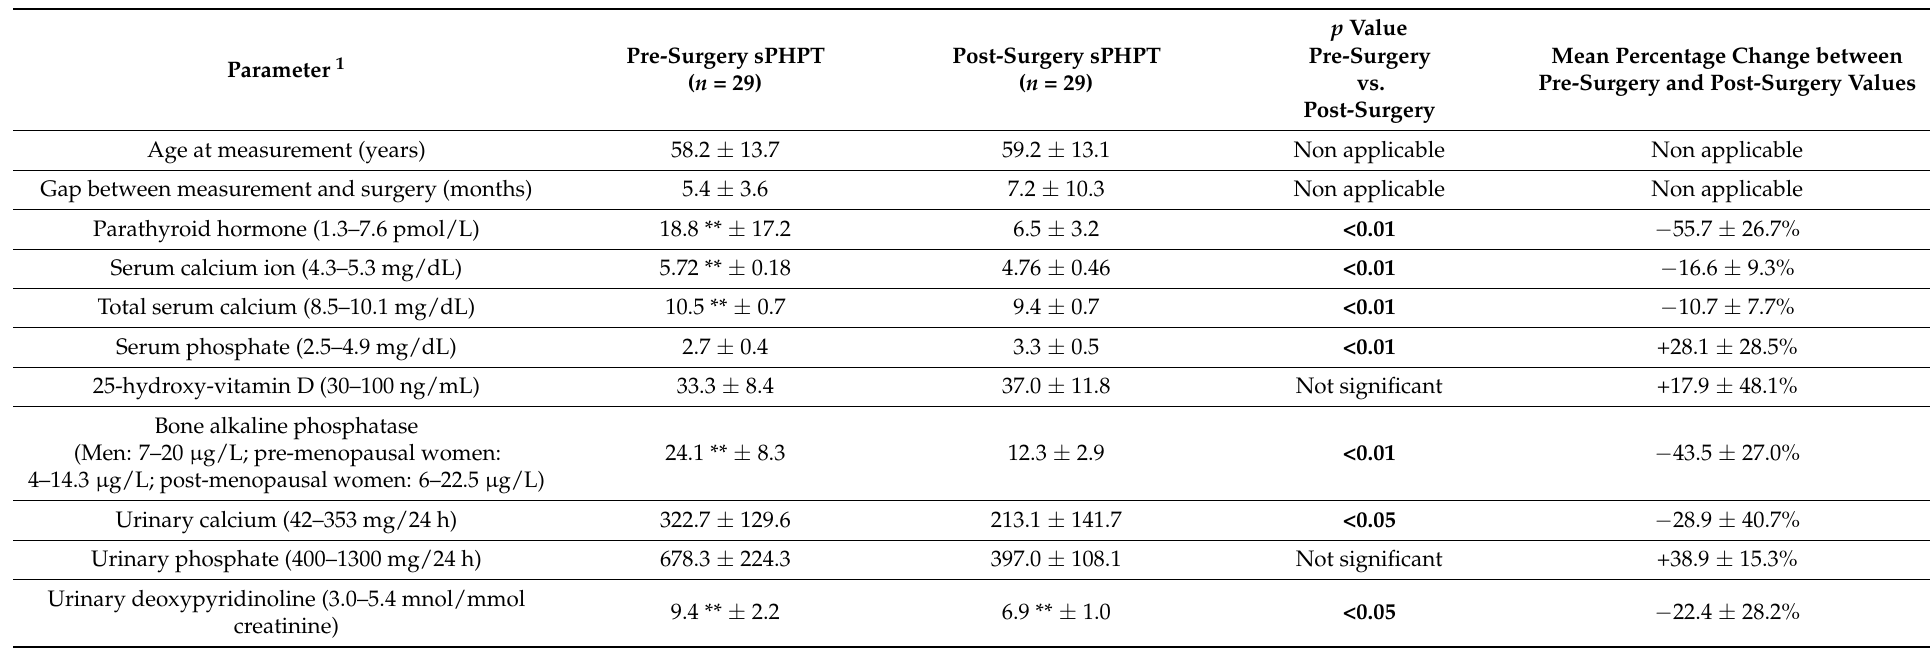
Table 3. Comparison of serum and urinary bone and mineral metabolism-related parameters, measured before and after PTX, in sPHPT